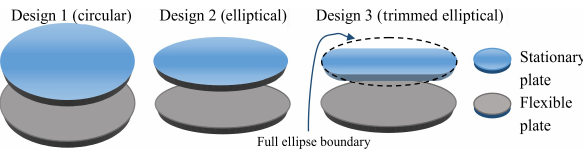
Figure 11. Capacitive sensor’s functional plates of the three de-